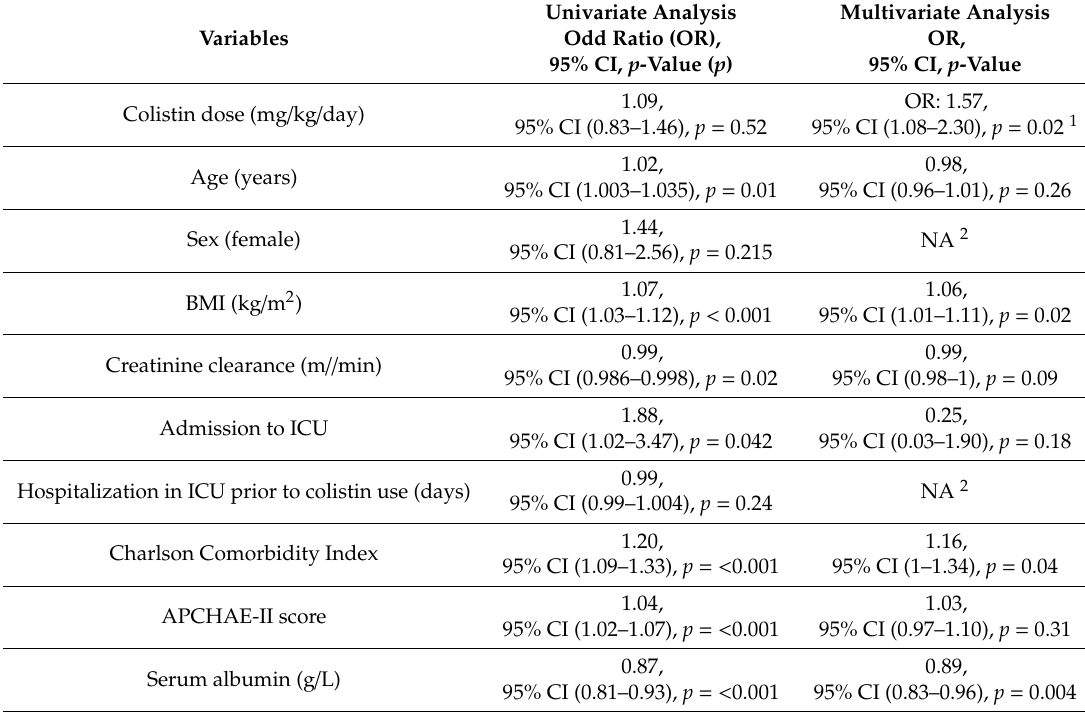
Table 2. Univariate and multivariate analysis for predictors of acute kidney injury